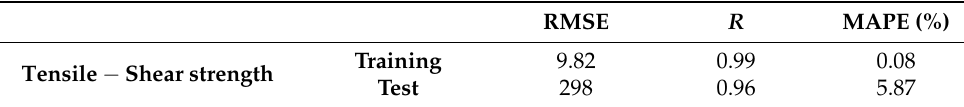
Table 6. Different criteria (RSME and MAPE) for TSS modeling.